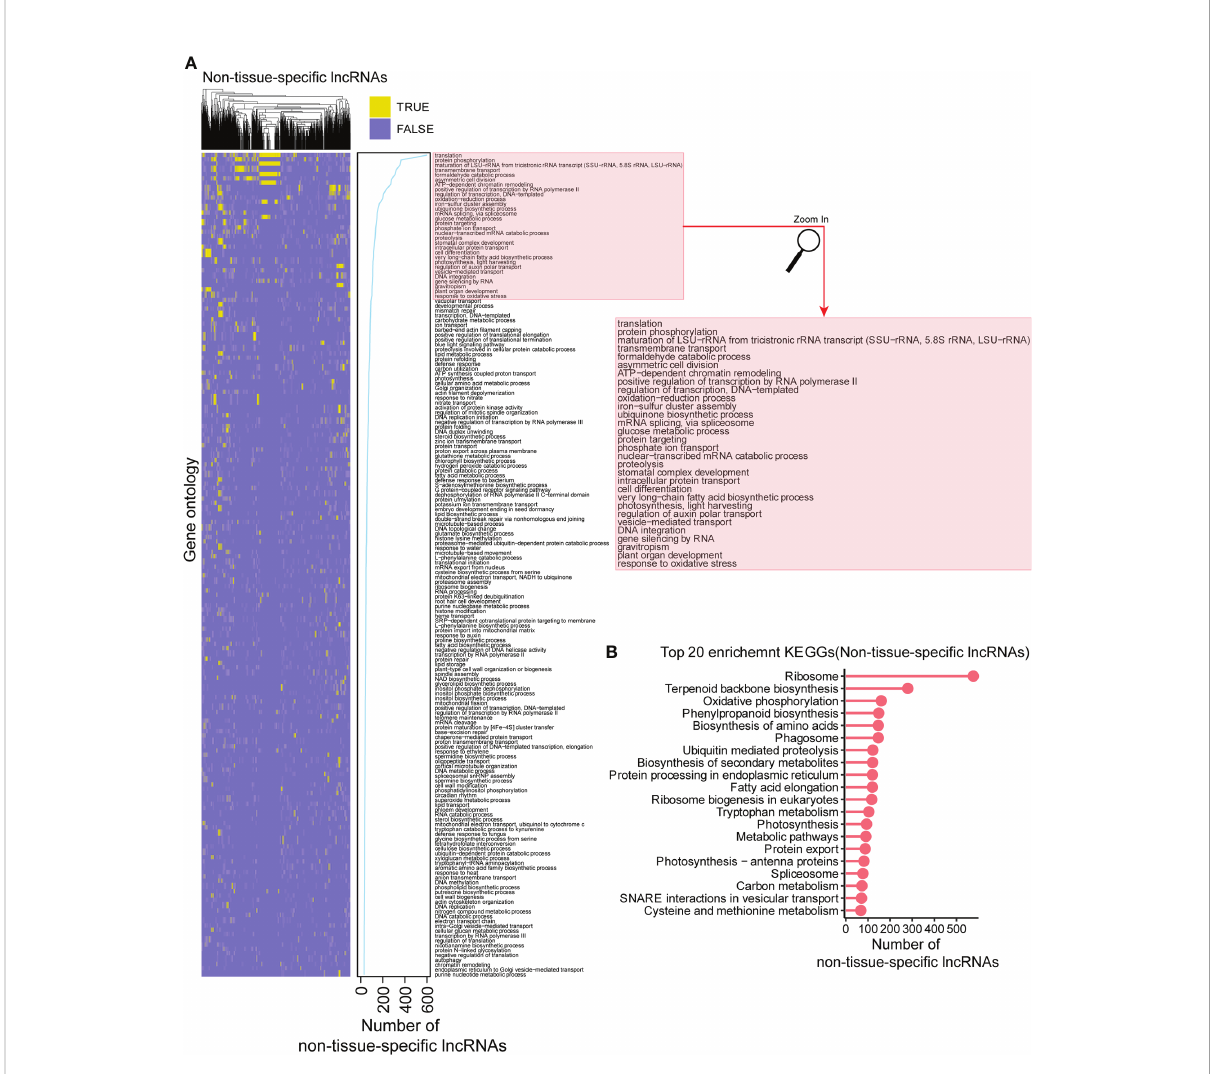
FIGURE 7 Functional pro fi le for the non-tissue-speci fi c lncRNAs. (A) The biological processes enriched in in at least 30 non-tissue-speci fi c lncRNAs. Yellow (TRUE) indicates the signi fi cant enrichment while light blue (FALSE) represents non-signi fi cant. (B) Top 20 enrichment KEGG pathways for the non-tissue-speci fi c lncRNAs. Y axis is the term of pathways, while X axis represents the number of non-tissue-speci fi c